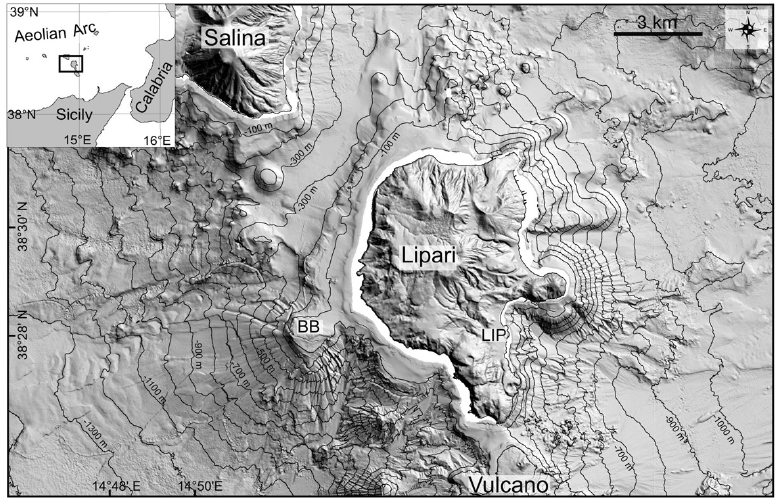
Figure 1. Shaded relief of Lipari edifice (modified from Casalbore et al. [2014c]). The white zone shows the area covered by the 2014 ultra- high resolution multibeam surveys discussed in this paper, where shallow-water bathymetric data were lacking from previous